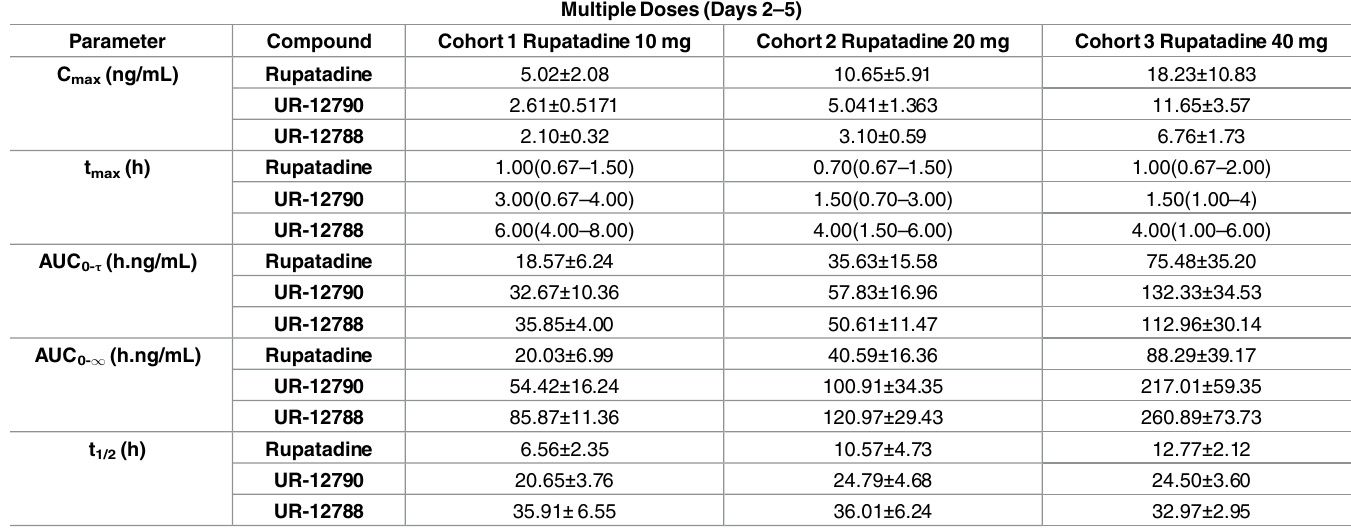
Table 3. Meanpharmacokinetic ( ± SD)parameters followingadministration of multipledosesof rupatadine(10, 20 and 40 mg). Median(min–max) values are presentedfor t max